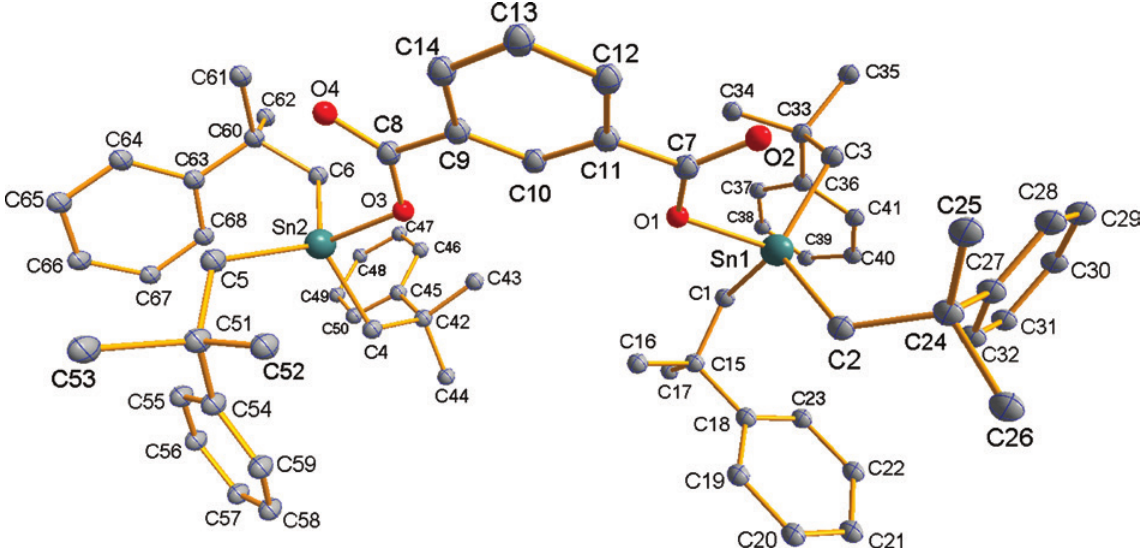
Figure 1: The molecular structure of 1 . Displacement ellipsoids are drawn at the 30% probability level; hydrogen atoms are omitted for